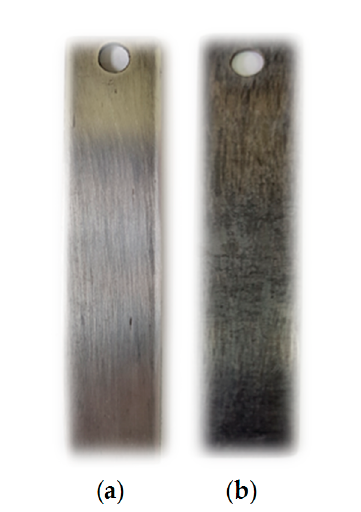
Figure 4. Electrodes before ( a ) and after ( b ) the experiment in the pure sulfolane at 230